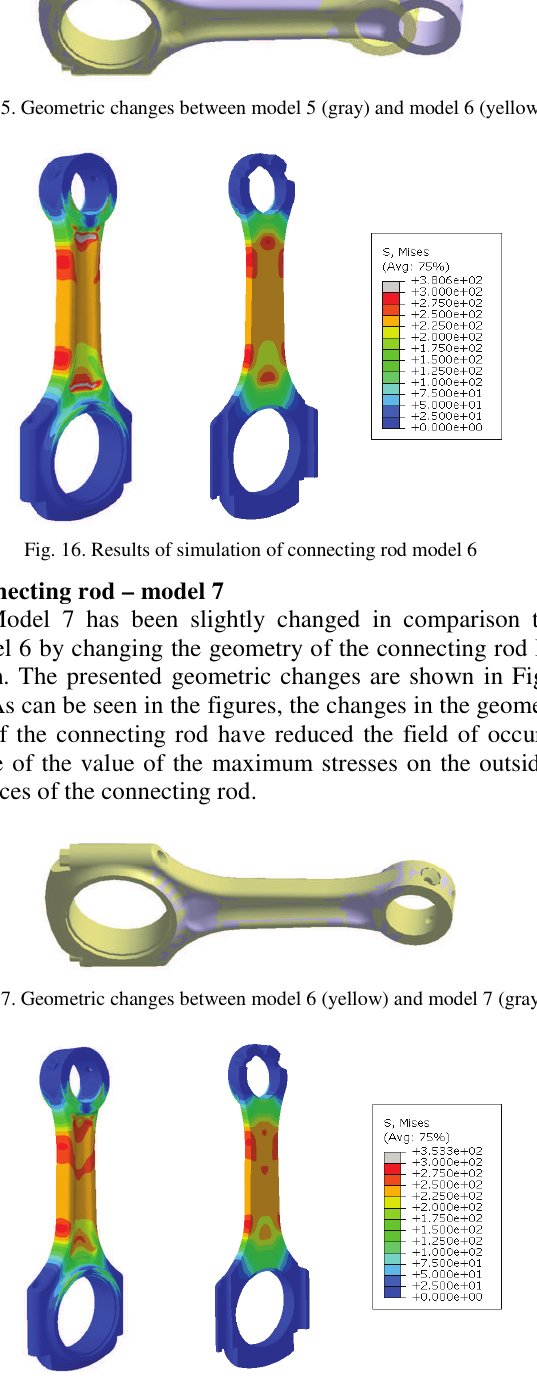
Fig. 18. Results of simulation of connecting rod model 7